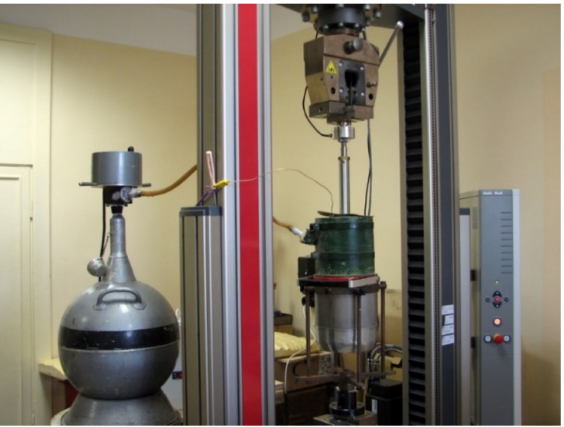
Figure 2. Testing machine equipped with cryogenic insulation facility for tests at 77